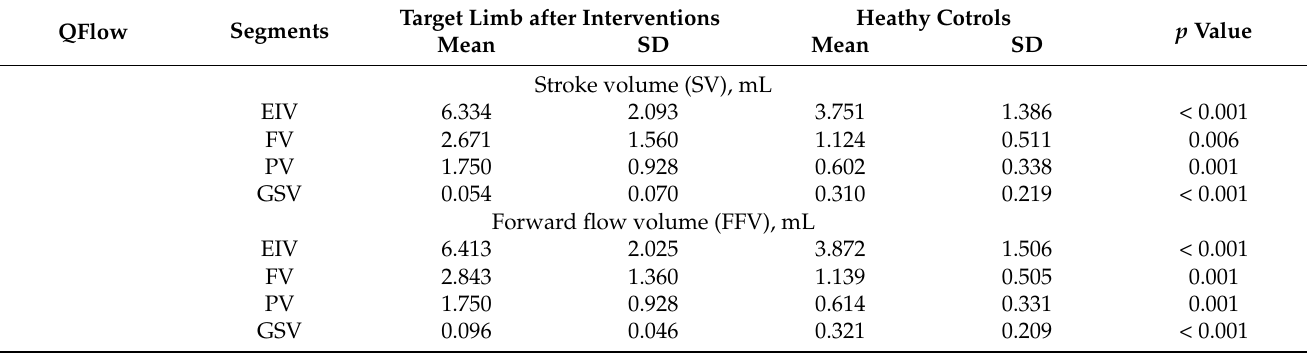
Table 3. Hemodynamics parameter between target limb (after intervention) and healthy